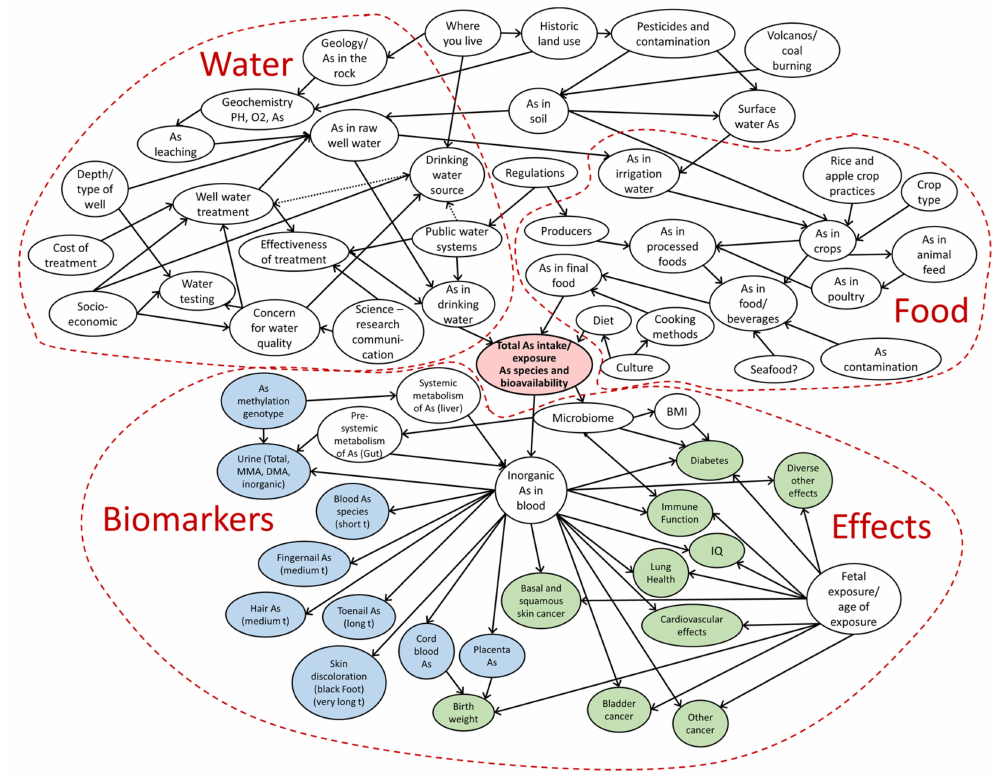
Figure 3. Dartmouth Superfund Research Program (DTMSRP) team expert model. Table 1. Categories and specific nodes from the Dartmouth Toxic Metals Superfund Research Program (DTMSRP) team expert